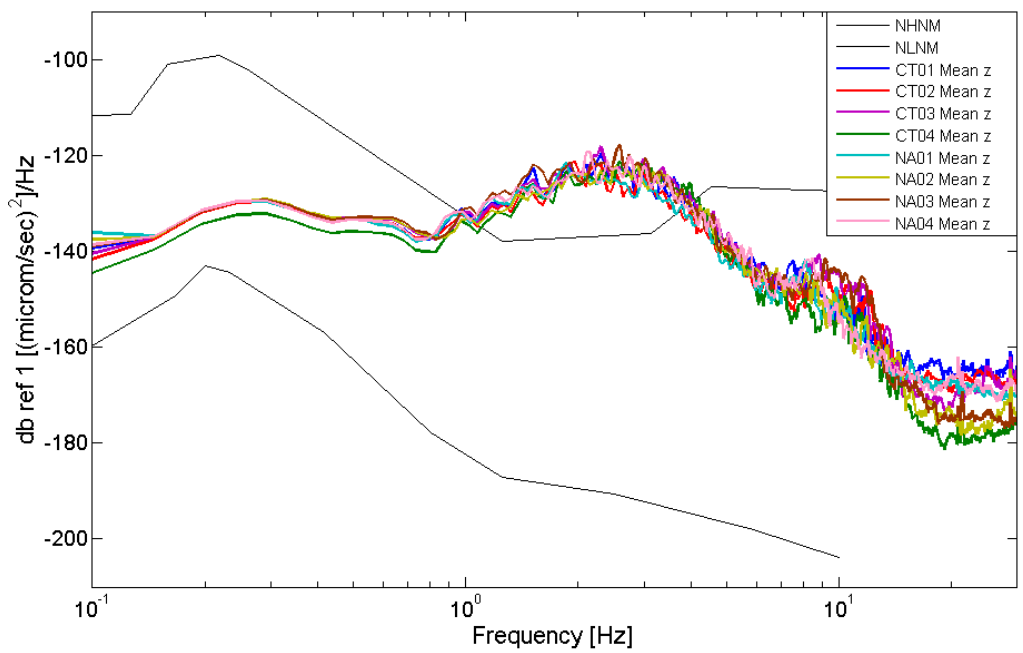
Figure 4. The vertical components frequency spectrum computed via a Fast Fourier Transform of one hour of